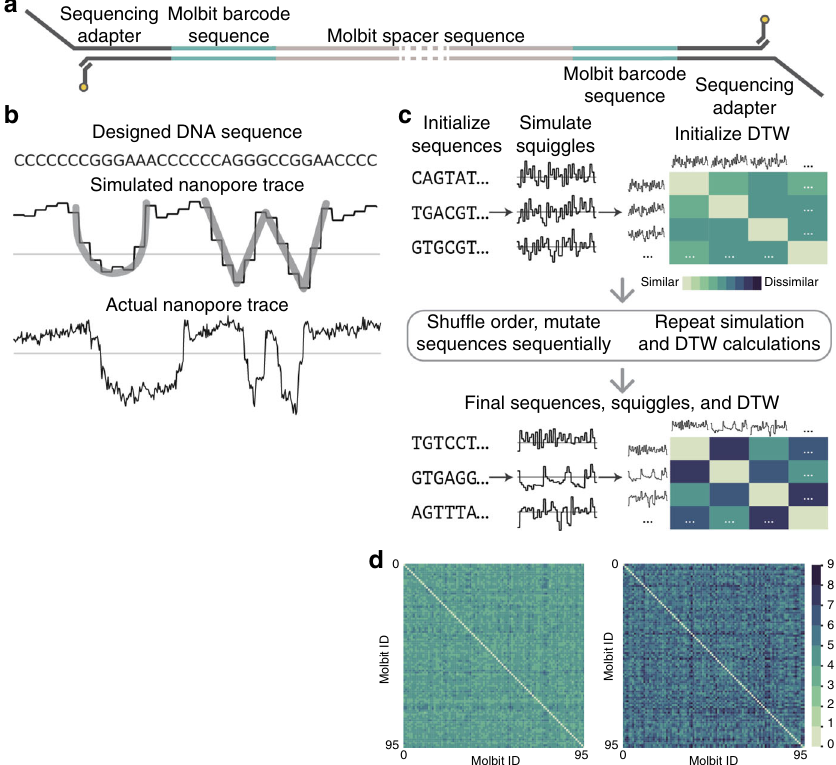
Fig. 2 Molbit design scheme. a Molecular bit (molbit) structure. The molbit sequence is attached to a spacer sequence via Golden Gate assembly to achieve a minimum length for sequencing and provide an additional encoding channel. Since the sequencing adapter is attached to both ends, the strand can be sensed from either direction. b The letters “ UW ” depicted visually in nanopore raw data (as opposed to encoded in the sequence contents). From top to bottom, the shown sequence was simulated using Scrappie and sequenced on the ONT MinION, demonstrating the viability of using simulations for designing intentional, arbitrary raw signal shapes. c Evolutionary model work fl ow. Each round of evolution begins with a set of sequences, their simulated squiggles, and pairwise Dynamic Time Warping (DTW) distances. The sequence order is randomized, and sequences are mutated one at a time, verifying DTW improvement (minimum and mean) after each attempt. d Dynamic time warping (DTW) scores before (left) and after (right) 31 iterations of the evolutionary model. After initialization, the minimum DTW similarity was 2.9 (mean 4.2 ± 0.4), and after evolution the minimum was 4.2 (mean 5.8 ± 0.8). Source data are provided as a Source Data fi design or synthesis. To do this, we inserted a DNA fragment set to different lengths as an additional encoding channel. Thus,